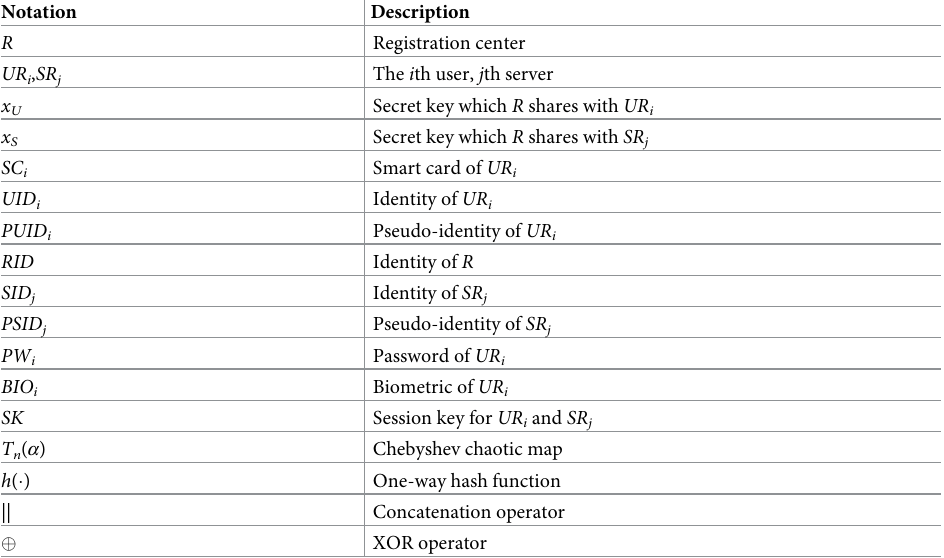
Table 3. Notation used in proposed